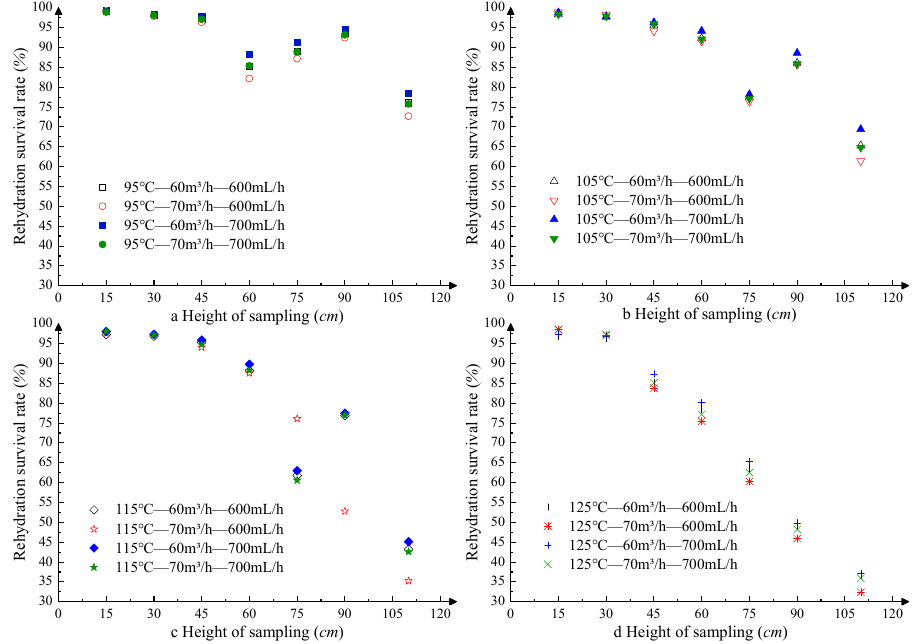
Figure 8 . Rehydration survival of yeast in each sampling cup under different test parameters. As shown in Figure 5 above, with increasing sampling height, the measured sam- pling point temperatures at the cup mouth of the sampling cup all showed a decreasing trend of speed reduction. The rate of temperature drops at the sampling site decreased obviously after sampling height of 15 cm and stabilized near the outlet temperature at sampling site temperature when the sampling height was 45 cm.